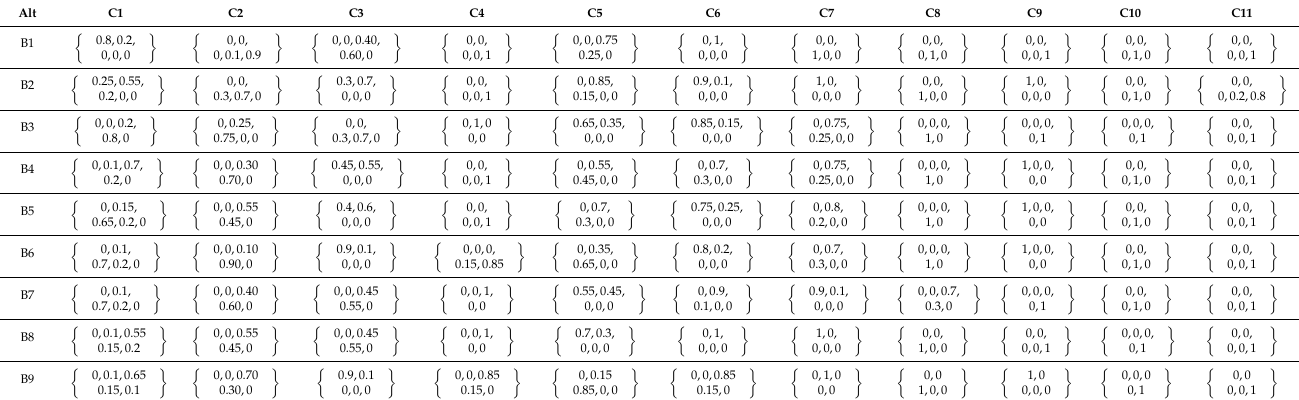
Table 4. Belief decision matrix of the alternatives assessments by the first decision group according to each criterion.